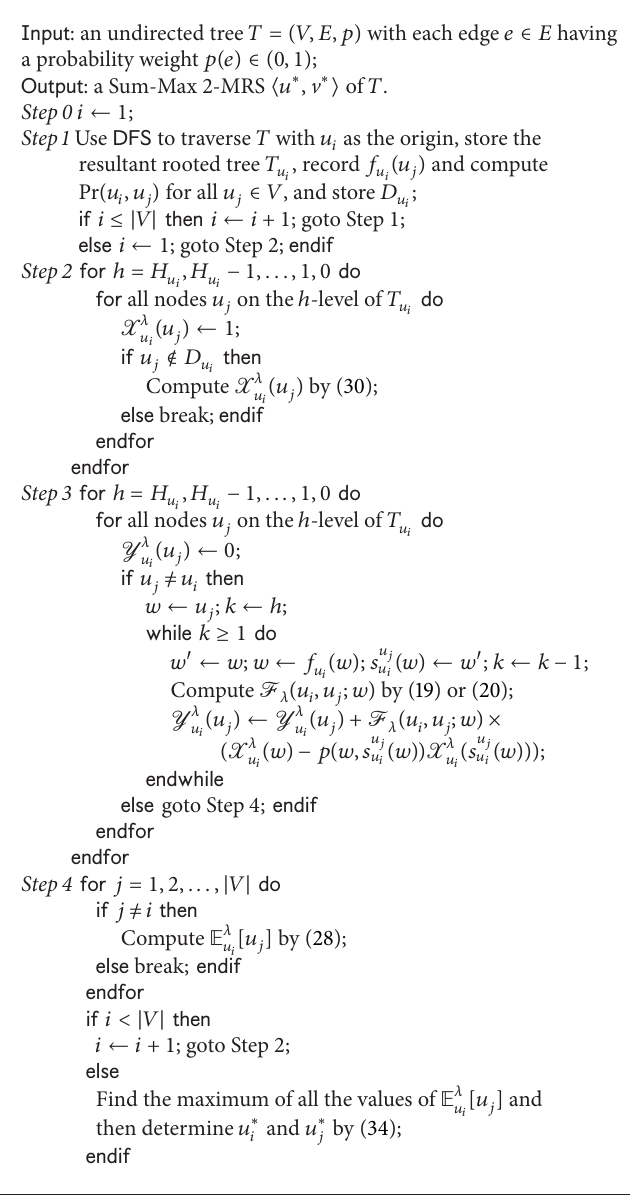
Algorithm 1: Algorithm SUM - MAX